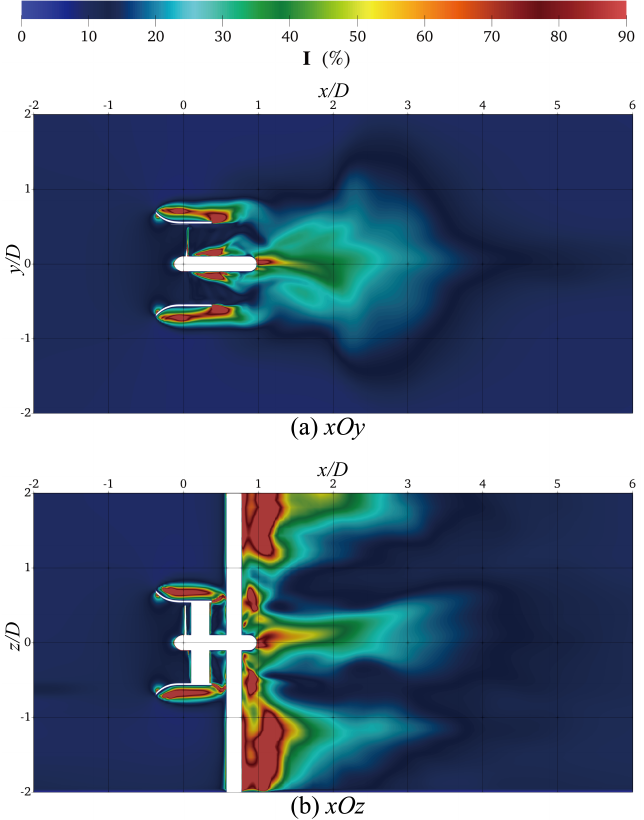
Figure 7. Contours of turbulence intensity ( I ) on horizontal and vertical plane ( TSR = 3.6 ) . On the other hand, the turbulent flow is slightly asymmetrical to the centerline on the vertical plane (Figure 7b). Similar to its distributions on the horizontal plane,